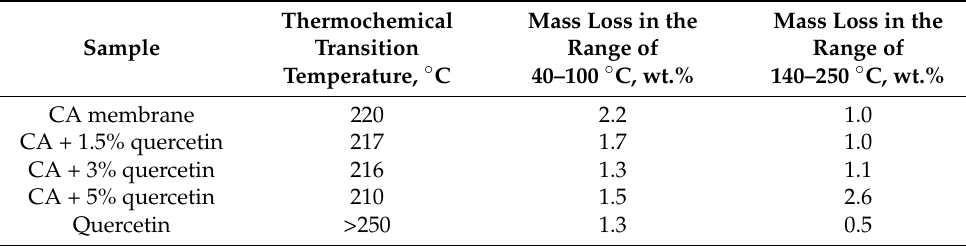
Table 1. Thermochemical transition temperature and mass loss within two different temperature ranges for CA and CA-quercetin